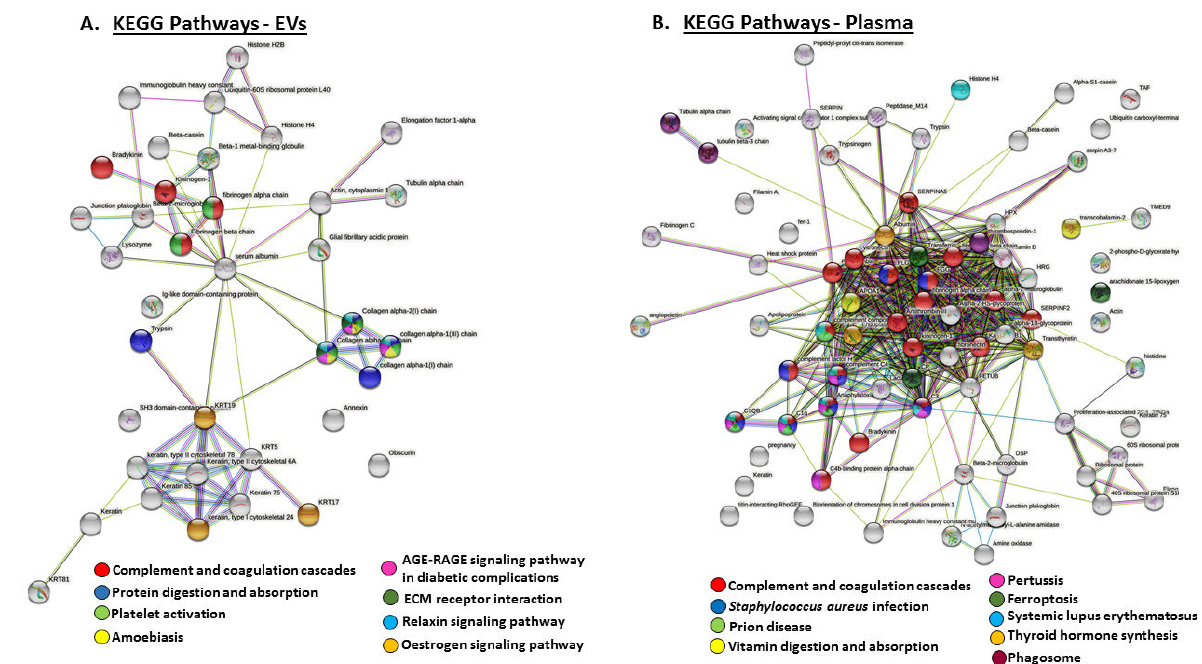
Figure 6. KEGG pathways for deiminated proteins identified in reindeer plasma EVs and whole plasma. Protein–protein interaction networks identified in reindeer plasma are based on known and predicted interactions in Bos taurus as a representative Artiodactyla for creation of the protein networks, using Searching Tool for the Retrieval of Interacting Genes/Proteins (STRING) analysis. ( A ) KEGG pathways in plasma EVs are highlighted, with eight pathways identified for the deimination protein networks. ( B ) KEGG pathways in whole plasma are highlighted; nine pathways were identified for the deimination protein networks. The color code for the specific KEGG pathways for both networks is indicated in ( A , B ),